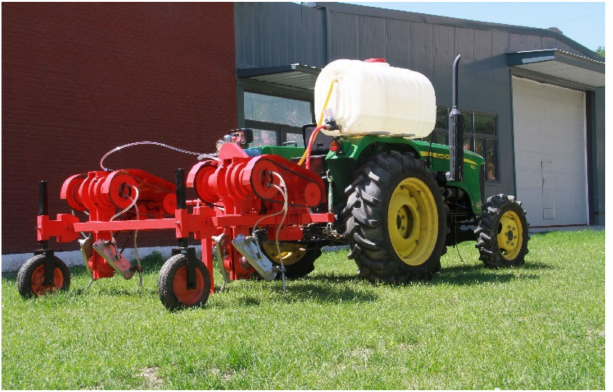
Figure 2. Photo of the deep-hole liquid fertilizer